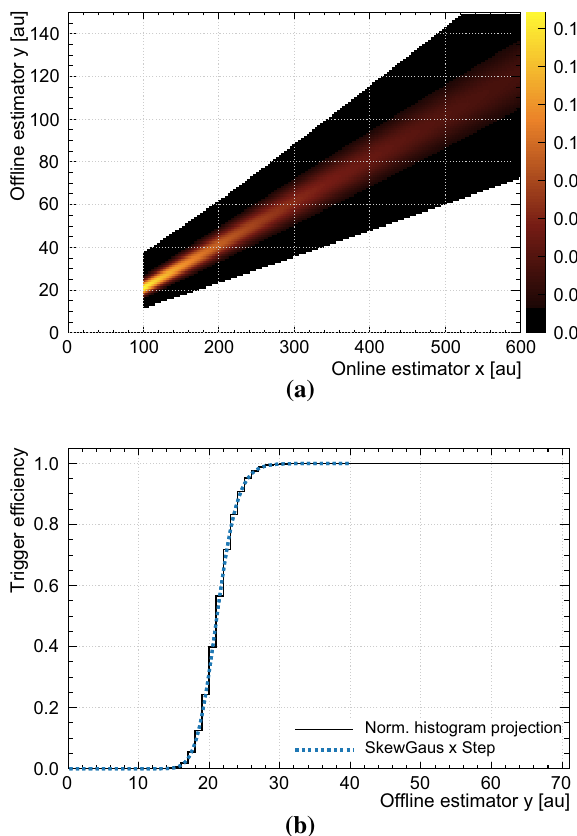
Fig. 8 Skewed Gaussian example with μ = 0 . 2 y , σ = 0 . 015 y , and λ = 0 . 7. a x vs y. b The normalized y profile. Also shown (blue dashed) is a fit to the curve with Eq.